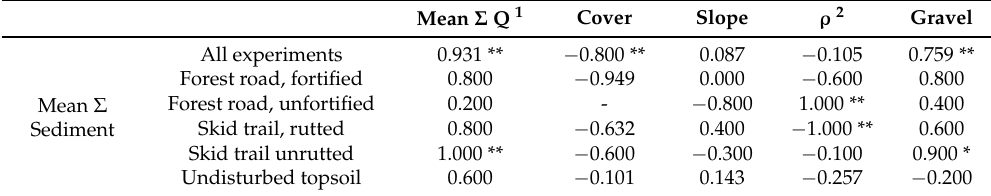
Table 12. Spearman-Rho correlations between mean runoff volumes and plot chracteristics. Mean Σ Q 1 Cover Slope ρ 2 Gravel All experiments 0.931 ** ´ 0.800 ** 0.087 ´ 0.105 0.800 ´ 0.949 Mean Σ Sediment